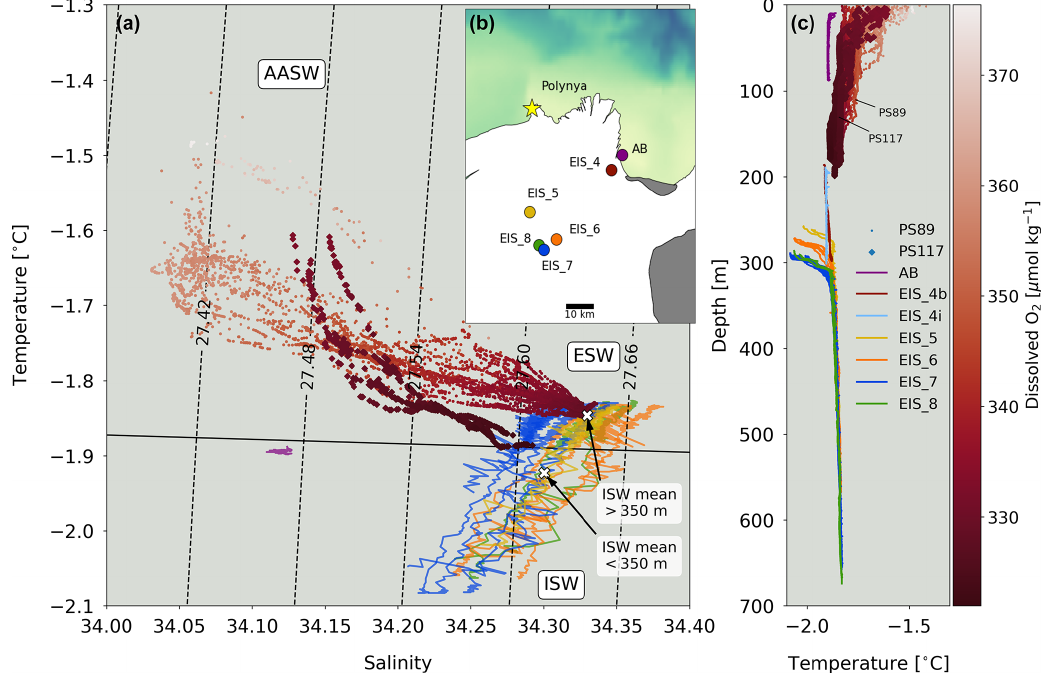
Figure 7. (a) Temperature–salinity diagram for PS89 (circles) and PS117 (diamonds) tidal observation periods, which are coloured according to dissolved oxygen concentrations. CTD profiles of the ice shelf’s cavity water were collected and made available by Smith et al. (2020a) (coloured lines). The cavity CTD profiles were taken by hot-water drilling through the ice at various locations on the ice shelf, which are shown on the map in (b) in corresponding colours to the profiles in (a) . AASW is Antarctic Surface Water, ESW is Eastern Shelf Water, and ISW is Ice Shelf Water. The average temperature and salinity of water deeper and shallower than 350m underneath the ice shelf are plotted as single white crosses. Contour lines indicate sigma- t (in kgm − 3 ). The black line indicates freezing point at mean atmospheric pressure. (b) Map of measurement locations of the Ekström Ice Shelf cavity CTD profiles by Smith et al. (2020a) denoted by “EIS_”, a measurement location in Atka Bay by Smith et al. (2020a) denoted with “AB”, and the sampling location of the tidal observations indicated by the yellow star. (c) Temperature profiles for PS89 (circles) and PS117 (diamonds) tidal observation periods, coloured according to oxygen concentrations, and for the hot-water drill CTD profiles underneath the ice shelf from Smith et al.